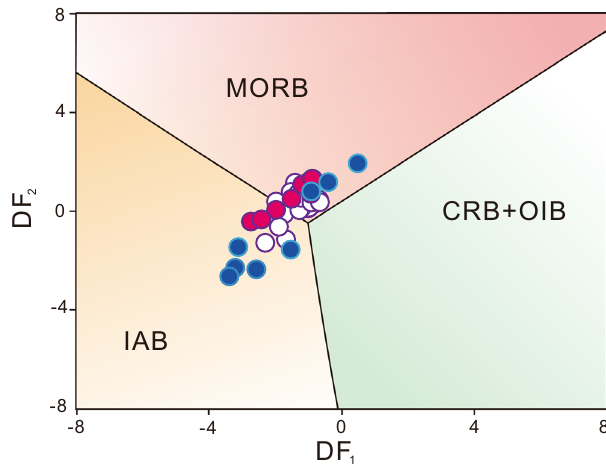
Fig. 9 Tectonic discrimination diagrams for the metabasites. Log- transformed immobile trace element tectonic discrimination adopted from Agrawal et al. 41 (symbols as for Fig. 8); DF 1 = 0.3518 log e ( La / Th ) + 0.6013 log e ( Sm / Th ) – 1.3450 log e ( Yb / Th ) + 2.1056 log e ( Nb / Th ) – 5.4763; DF 2 = – 0.3050 log e ( La / Th ) – 1.1801 log e ( Sm / Th ) + 1.6189 log e ( Yb / Th ) + 1.2260 log e ( Nb / Th ) – 0.9944. MORB Mid-Ocean Ridge Basalts, OIB Ocean Island Basalts, IAB Island Arc Basalts, CRB Continental Rift Basalts. Our samples plot along the distinctive SSZ mantle enrichment trend re fl ecting slab-derived fl uid metasomatism, which is also explicitly documented in the great amount of ultrama fi c-ma fi c volcanic rocks derived from both Cenozoic intra-oceanic arcs and Archean equivalents, the former (MORB trend) is represented by Tonga, Mariana, Kermadec, Kuril, Aleutian, and Scotia arcs; the latter (transitional MORB to IAT) preserved in the Eoarchean (3.8 – 3.7 Ga) Isua greenstone belt, Mesoarchean (3075 Ma) Ivisaartoq – Ujarassuit greenstone belt and (2970 Ma) Fiskenæsset complex 69 and Neoarchean Zanhuang tectonic mélange 26